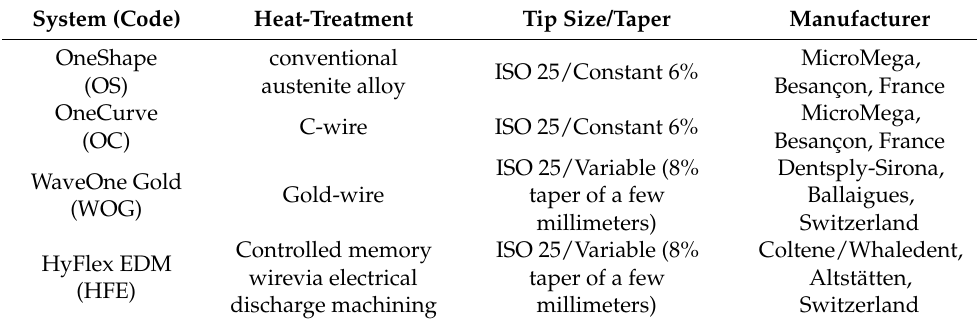
Table 1. NiTi rotary instrument systems tested in this